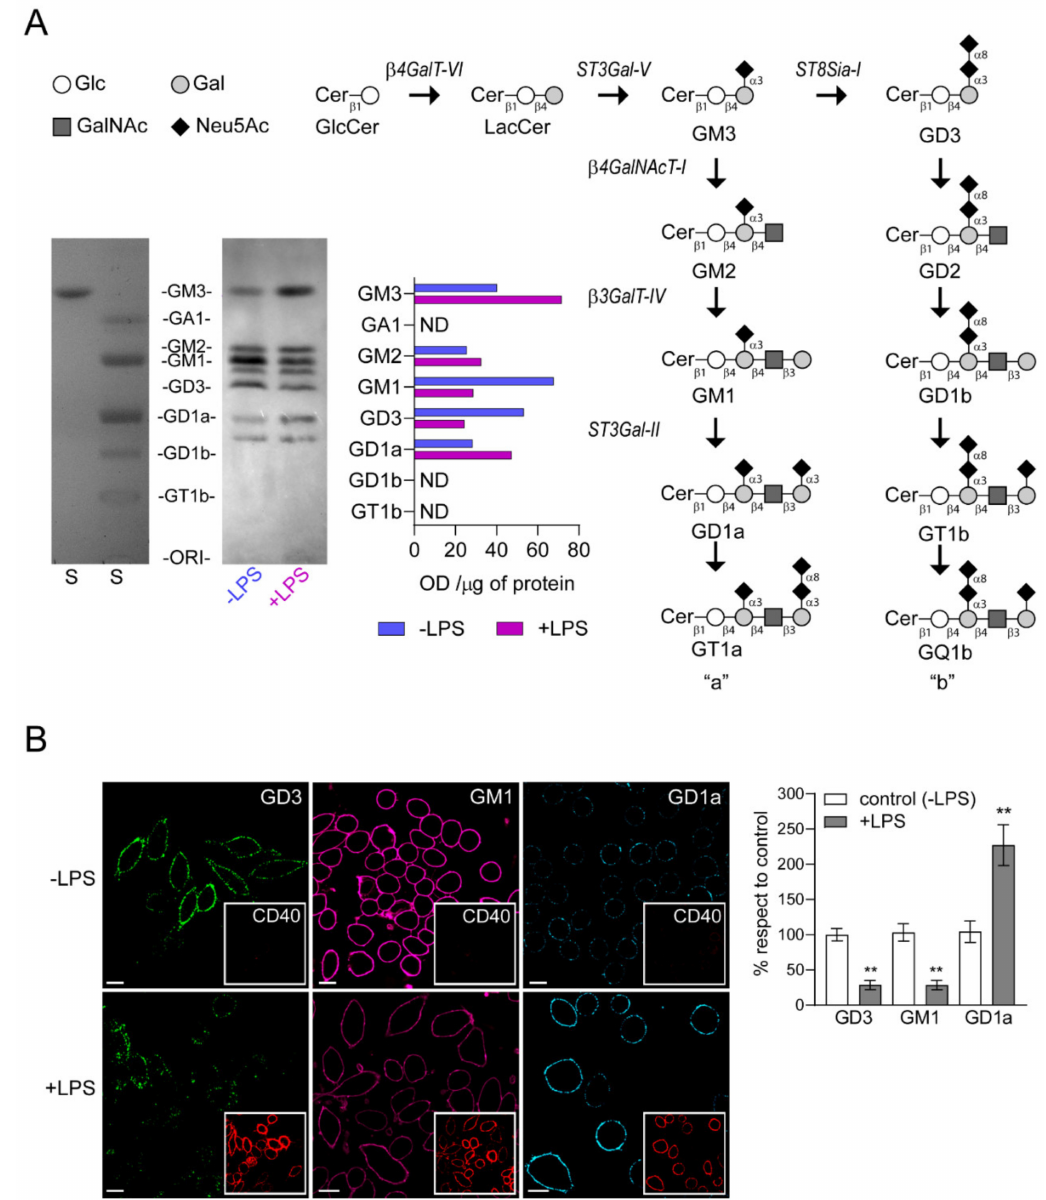
Figure 3. Change in the expression of gangliosides in RAW264.7 cells stimulated by LPS. ( A )